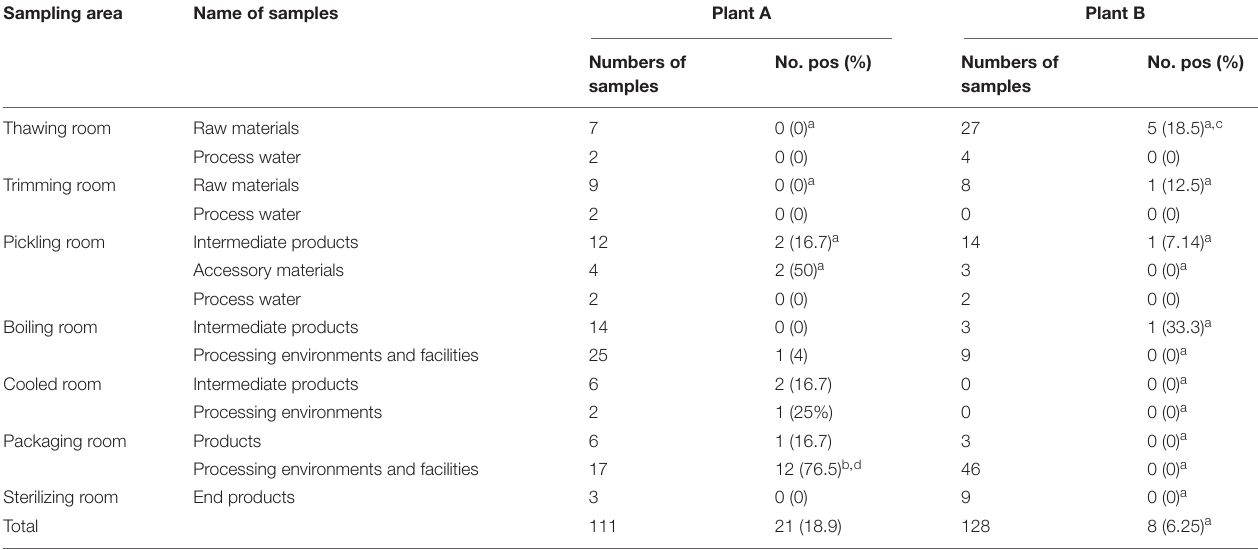
TABLE 1 | Occurrence of L. monocytogenes in the different areas, sources investigated in two RTE meat plants in this study. Sampling